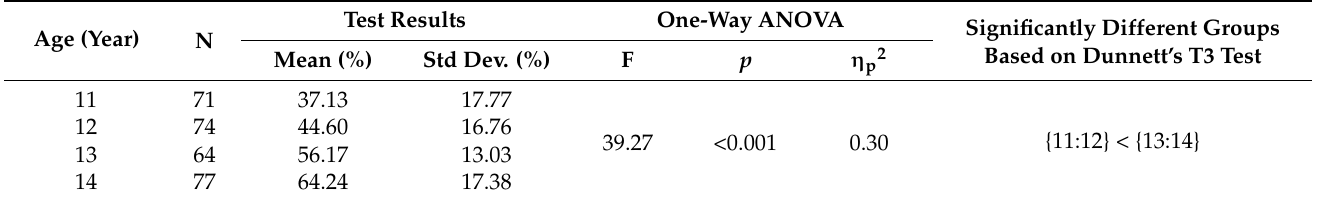
Table 6. Distribution of test score by age in the “produce” domain of the visual communication test.